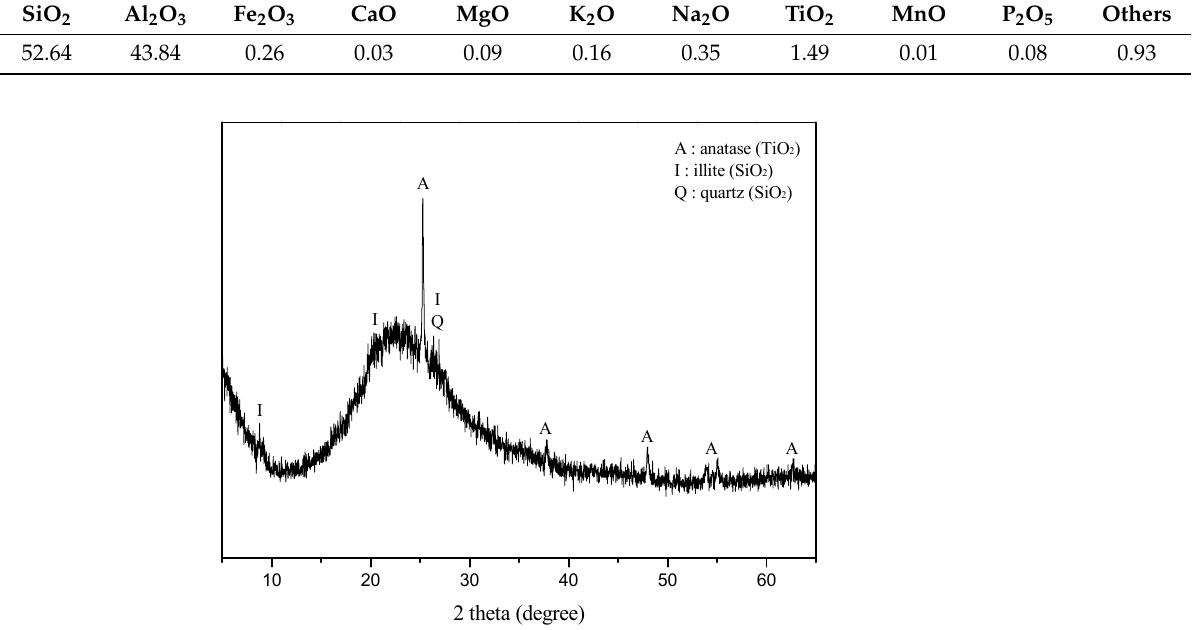
Figure 1. X-ray diffraction pattern of metakaolin in this study. Metakaolin was composed of amor- phous and several crystalline phases such as anatase, illite, and quartz as impurities. The center of the amorphous hump was located at 2 θ 22.9°.